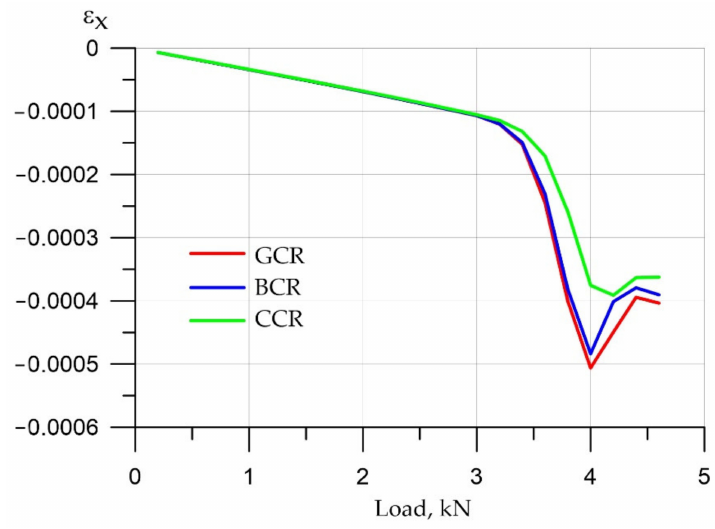
Figure 15. Concrete deformations in the compressed zone (top layer, top